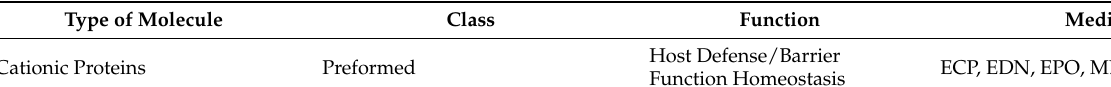
Table 1. Eosinophil mediators (modified from